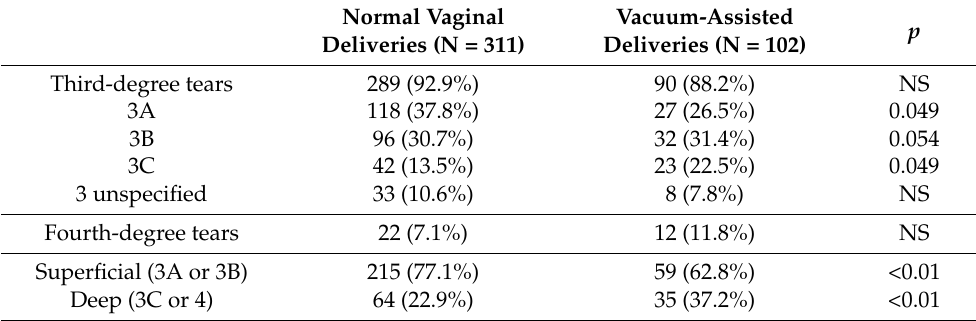
Table 1. Comparison of OASIS according to the mode of delivery. Normal Vaginal